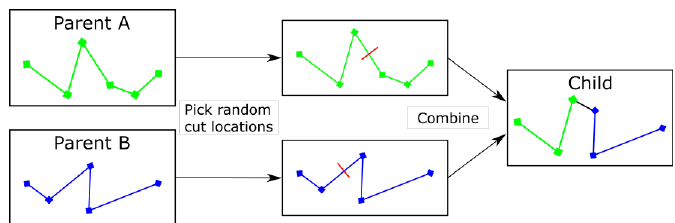
Figure 2. The function of a Genetic Algorithm crossover operator in a 2D path optimisation example.